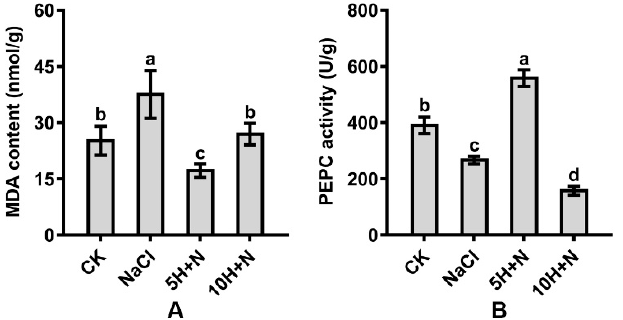
Figure 7. Effects of exogenous H 2 O 2 on MDA content ( A ) and PEPC activity ( B ) of Tartary buck- wheat under NaCl stress. CK: control, H 2 O foliar spray + H 2 O irrigation, NaCl: H 2 O foliar spray + 150 mmol · L − 1 NaCl irrigation, 5H + N: 5 mmol · L − 1 H 2 O 2 foliar spray + 150 mmol · L − 1 NaCl irrigation, 10H + N: 10 mmol · L − 1 H 2 O 2 foliar spray + 150 mmol · L − 1 NaCl irrigation. MDA: malondialdehyde content, PEPC: phosphoenolpyruvate carboxylase activity. All values are expressed as mean ± SD. According to Duncan’s multiple comparisons, different letters represent significant differences among different treatments ( p <